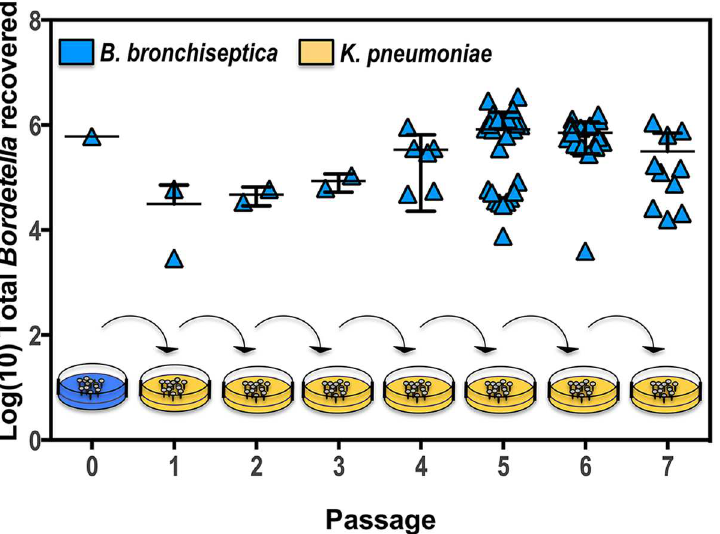
Fig 6. B . bronchiseptica maintains a stable association with D . discoideum . D . discoideum sori grown on a lawn of B . bronchiseptica strain RB50 (blue) were collectedin 1 mL PBS. One aliquotwas enumerated (Passage0), while another aliquot was used to inoculatea lawn of K . pneumoniae (Passage1). Amoeba sori that developedon the K . pneumoniae lawn (orange) were then collected,enumerated, and used to inoculatea new lawn of K . pneumoniae (Passage2). Collection,enumeration, and passagingwere repeated as indicated. For further details, please see S1 Data.